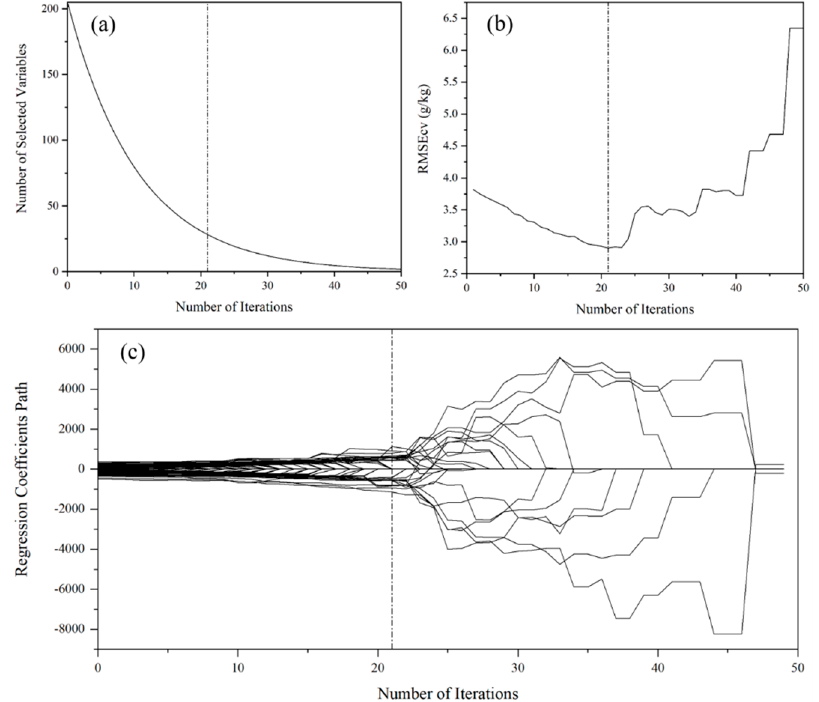
Figure 4. Competitive adaptive reweighted sampling (CARS) variable selection of Log (1 / R) spectra: ( a ) the number of sampled variables; ( b ) 5-Fold root mean squared error of cross-validation (RMSE cv ) values; and ( c ) regression coefficient path of each spectral variable during the 50 iterations.